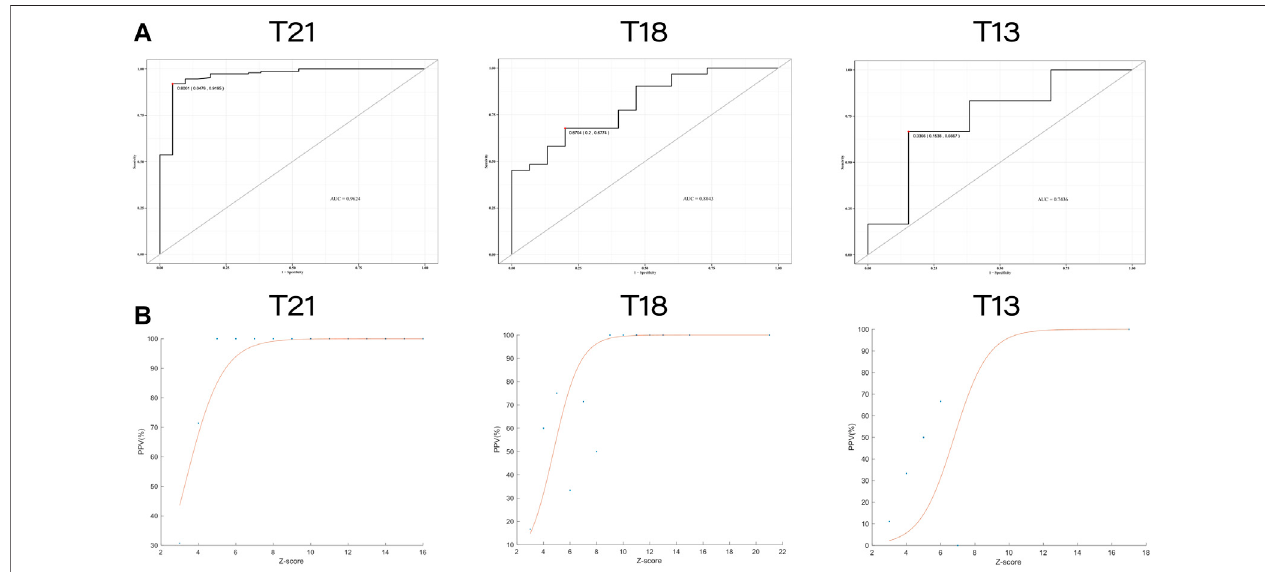
FIGURE 1 | The receiver operating characteristic (ROC) curves and trend curves between Z-score and the positive predictive value. (A) The ROC curves of T21, T18, and T13. The area under the curve (AUC) were 0.9624, 0.8043 and 0.7436, respectively. (B) The trend curves of T21, T18 and T13 with S-curve model ( f ( x ) (cid:2) 1 ). 1 + a 0 e − x